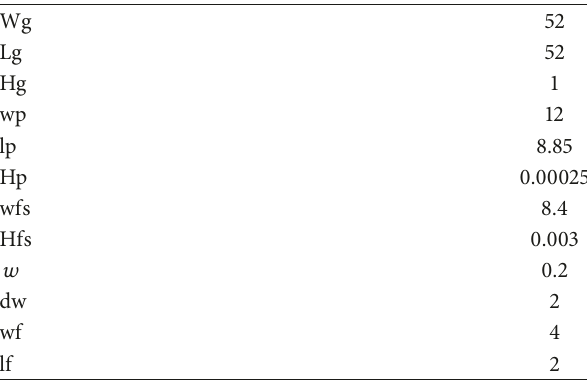
Table 1: Parameters of the proposed antenna (units: mm).